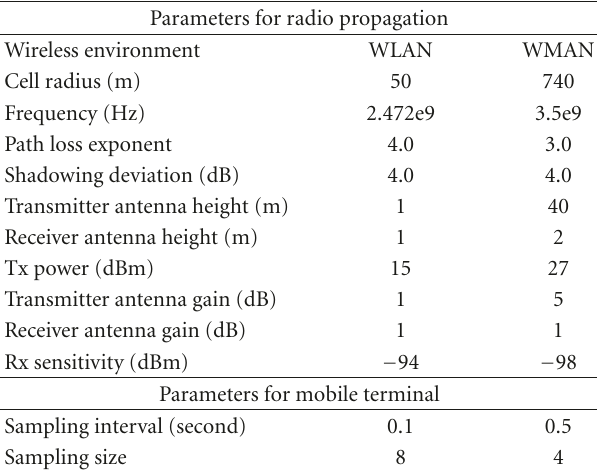
Figure 7: Examples of straight movement trajectory. Table 1: Default parameters for the simulation of UMD mecha-